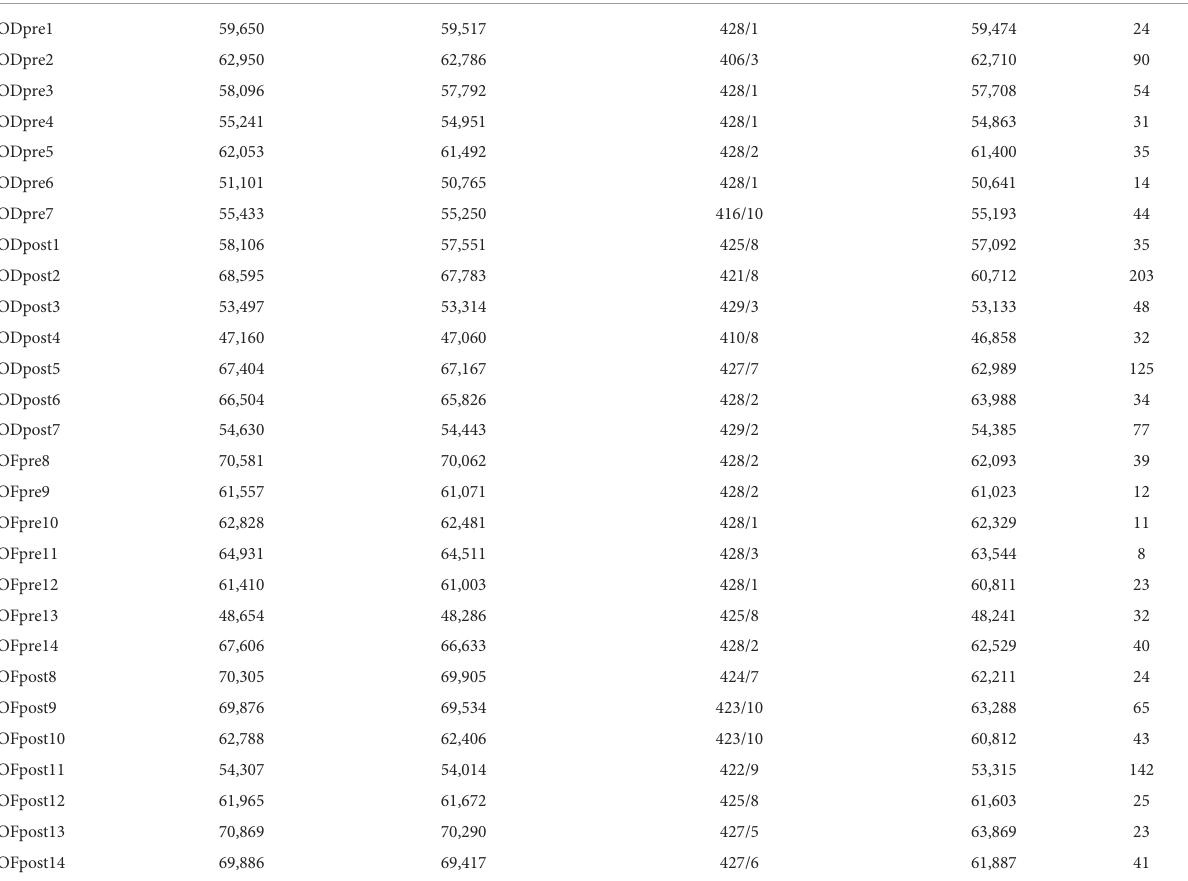
TABLE 3 Sample data volume output and ASV/OTU result